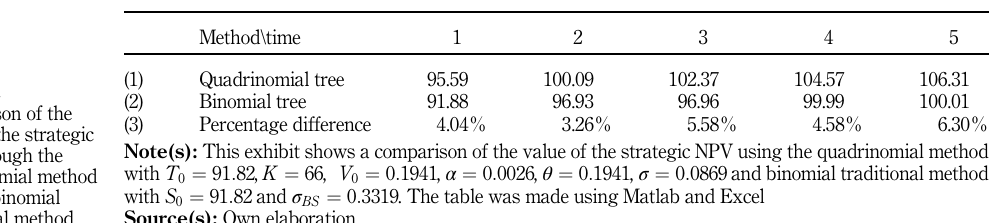
Table 4. Equivalent values of the parameters for the GARCH (1,1) and GARCH-diffusion processes